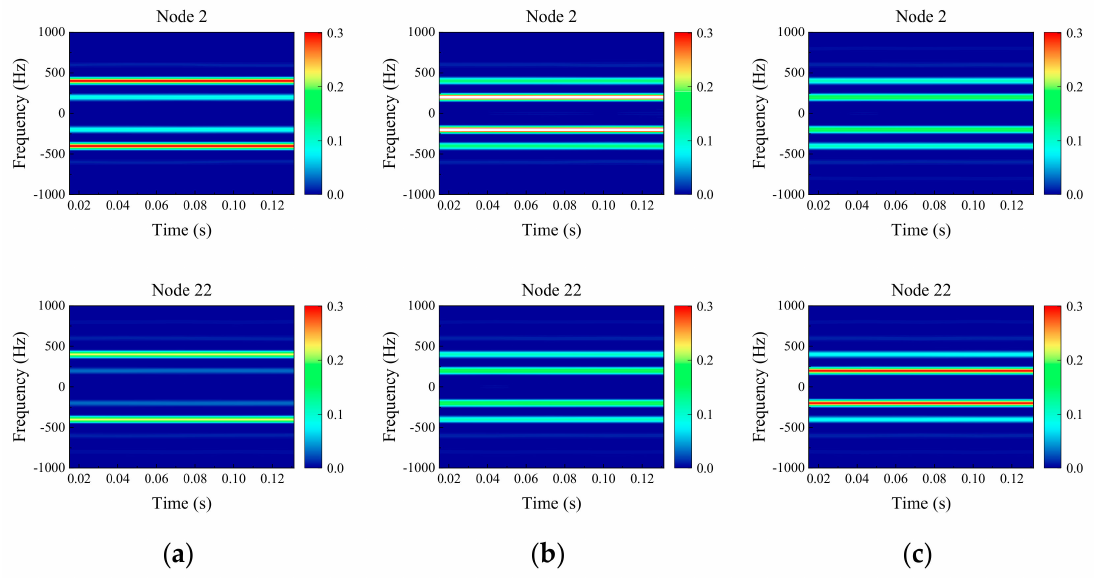
Figure 8. Time-frequency diagram of imbalanced and misaligned coupling faults: ( a ) value of imbalance 20 × 10 − 5 kg · m. ( b ) value of imbalance 100 × 10 − 5 kg · m. ( c ) value of imbalance 200 × 10 − 5 kg ·